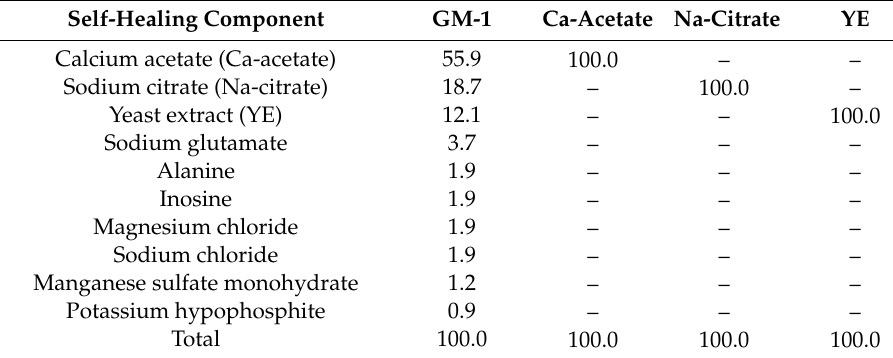
Table 2. Composition of tested growth media (% by mass).